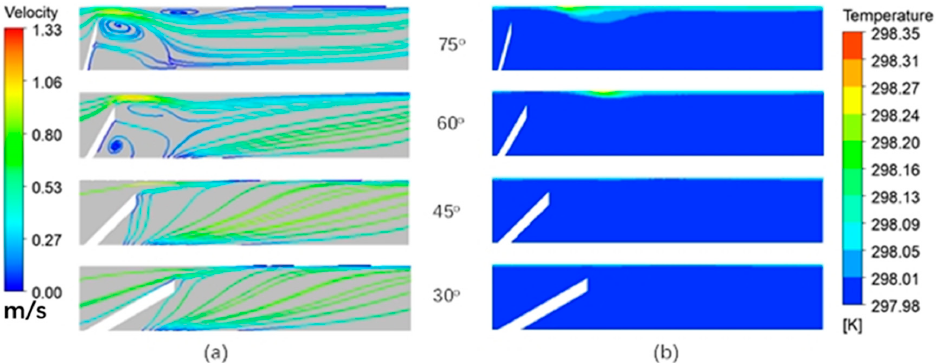
Figure 9. Temperature contour and streamline at YZ plane (P = 5 mm, N = 5 Re = 1500): ( a ) streamline; ( b ) temperature contour.